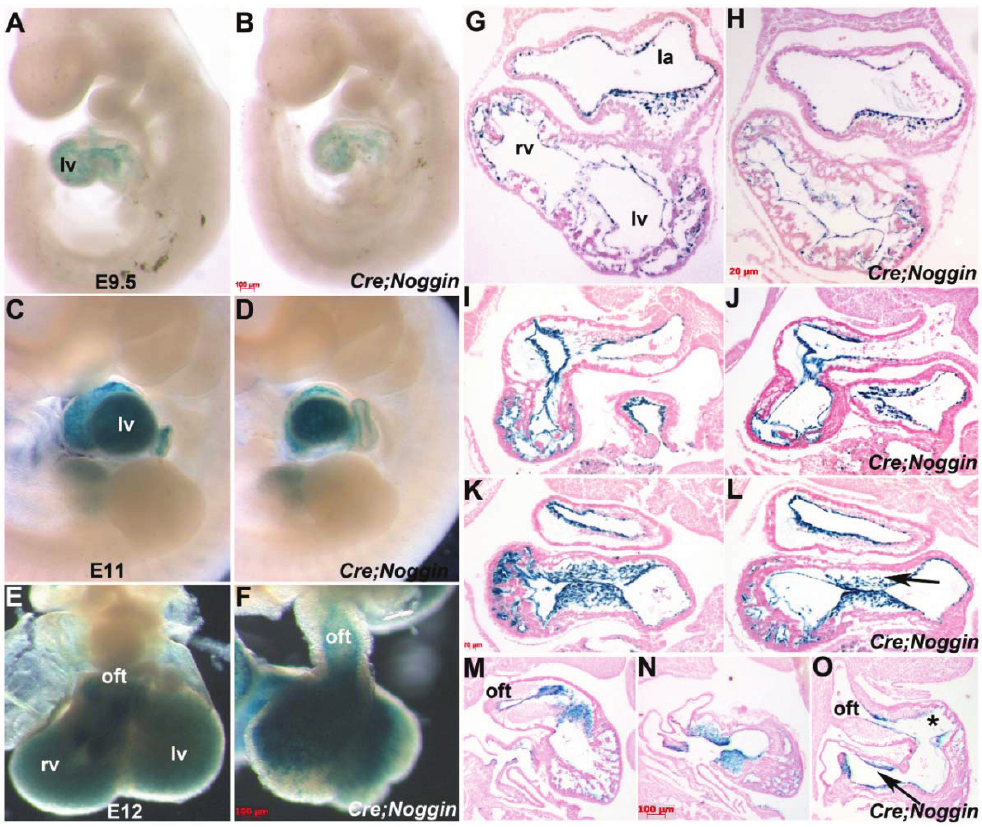
Figure 2. R26r reporter analysis of Noggin overexpressing lineages. ( A – D ): Left sided views of wholemount X-gal staining of control Nfatc1 Cre /R26r ( A , C ) and mutant pMes-Noggin/Nfatc1 Cre /R26r ( B , D ) embryos at E9.5 ( A , B ) and E11 ( B , D ) developmental stages, showing that Cre recombinase-mediated lacZ expression (blue) is restricted to the heart. Note lacZ staining reveals no obvious differences between control and Nog End mutants hearts, although the E11 Nog End mutant’s heart is smaller; ( E , F ): Isolated control and Nog End E12 hearts viewed frontally, reveals that Nfatc1 Cre /R26r –mediated lacZ reporter expression is still present in mutant heart ( F ) but that it is highly dysmorphic, misshapen and undersized; ( G – O ): Representative matched views of control E10 ( G ), E10.5 ( I , K ), E11 ( M , N ) and Nog End mutant E10 ( H ), E10.5 ( J , L ), E11 ( O ) serial sections X-gal stained and counterstained with eosin. Transverse sections of E10 control ( G ) and Nog End hearts ( H ) showed that lacZ expression was similarly localized in the endocardium and endocardial-derived cushion mesenchymal cells at the atrioventricular canals. E10.5 lacZ stained sagittal heart sections revealed that Nog End mutant atrioventricular cushion is reduced in cellularity (arrow in ( L )) when compared to control, littermate ( K ); Additionally, the Nog End endocardium is detached from the underlying mutant trabeculae ( J , L ); Transverse sections of the X-gal stained E11 control ( M , N ) and mutant ( O ) hearts illustrates the hypoplastic endocardially-derived OFT (indicated via *) and atrioventricular cushions (arrow in ( O) ), the reduced trabeculae and detached endocardial lining; Note however, that Nog End neural-crest-derived OFT cushions are grossly normal in cellularity ( O ); Scale bars: ( A – F ) = 100 μm; ( G – L ) = 20 μm; ( M – O ) = 100 μm. Abbreviations: la, left atria; lv, left ventricle; oft, outflow tract; rv, right